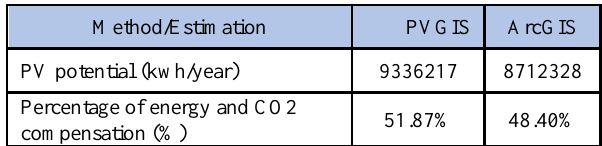
Table 2 . The results of PV potential using the two